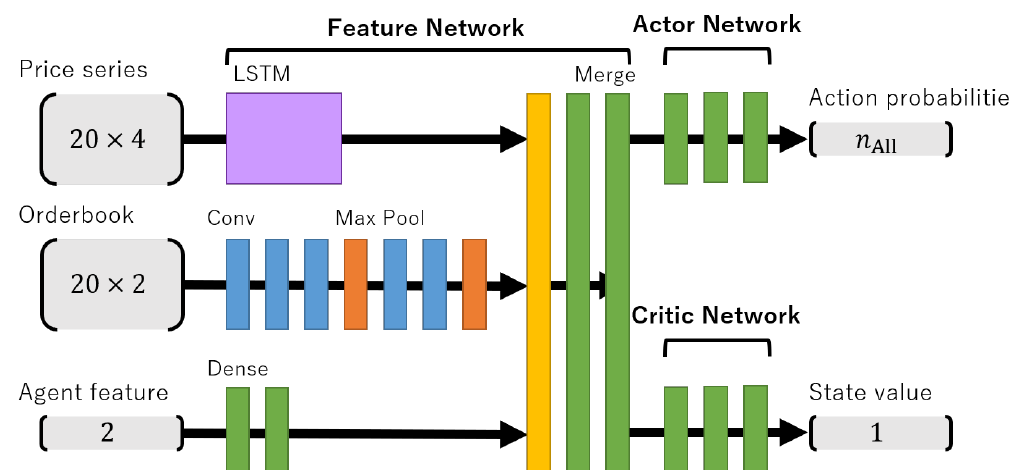
Figure 2. Overview of the A2C network used in this research ( n market = 1). The network takes price series, orderbook feature and agent feature as input variables and outputs action probabilities and state values. Purple, blue, orange, green, and yellow boxes in the network represent LSTM, convolutional, max pooling, dense, and merge layers, respectively. LSTM layers have tangent hyperbolic activation. Convolutional and dense layers except the last layers of actor and critic networks have ReLU activation. Action probabilities are calculated by applying softmax activation to the output of actor